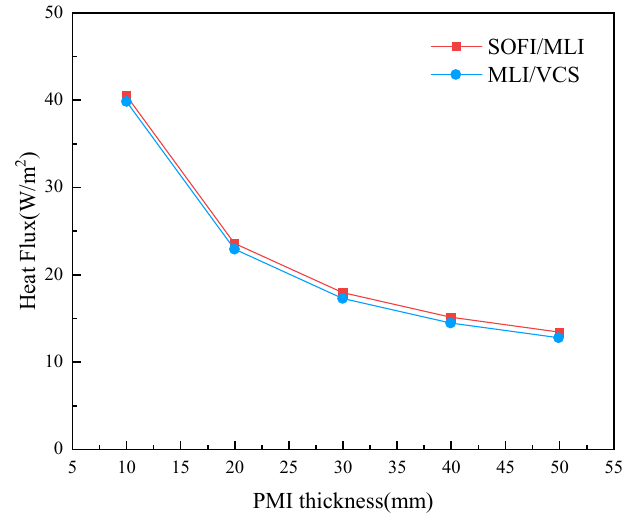
Figure 7. Heat fl ux under di ff erent adiabatic conditions. Figure 7. Heat flux under different adiabatic conditions.